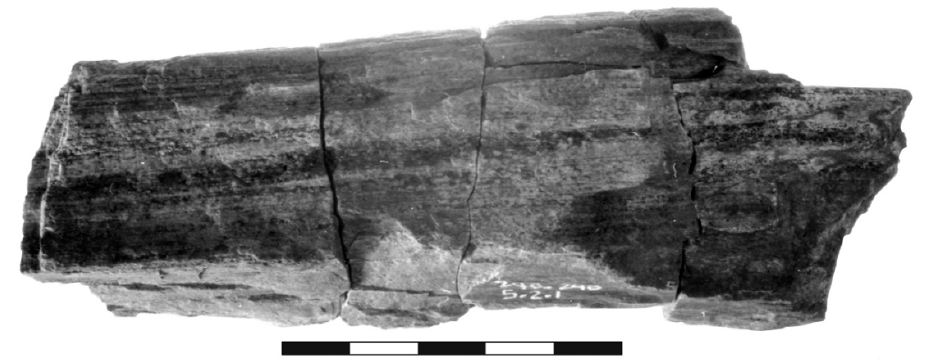
Figure 1. Petrified wood found during an excavation at Aguateca archeological site, showing the reassembly of angular fragments. Scale bar = 5cm.